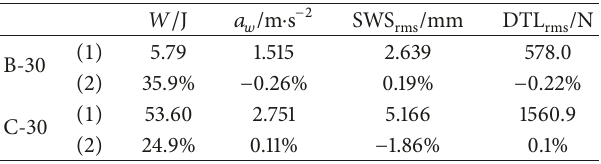
Table 3: Experiment results with mode-switching of the superca-